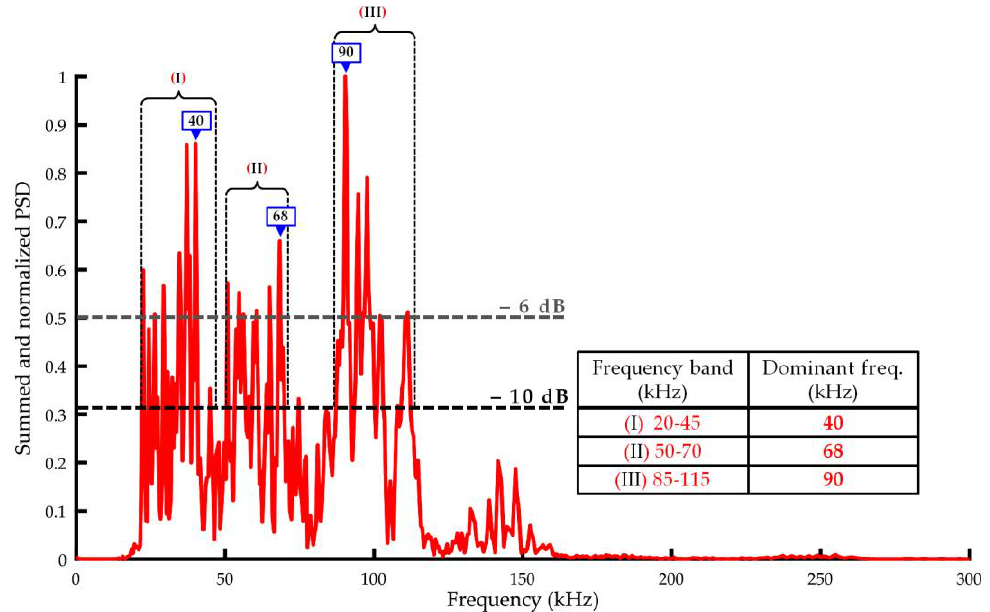
Figure 16. Summed and normalized PSD obtained for all investigated types of PD.